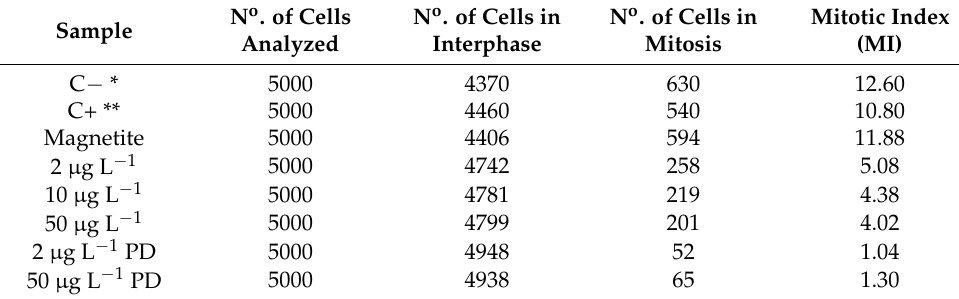
Table 5. Number of dividing cells and mitotic